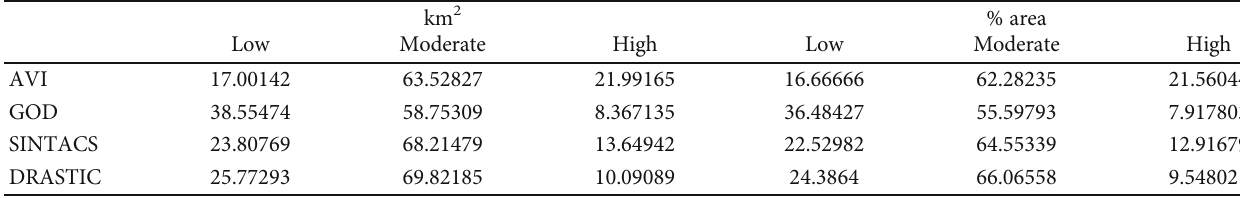
Table 13: Comparison between the areas representing the vulnerability classes.